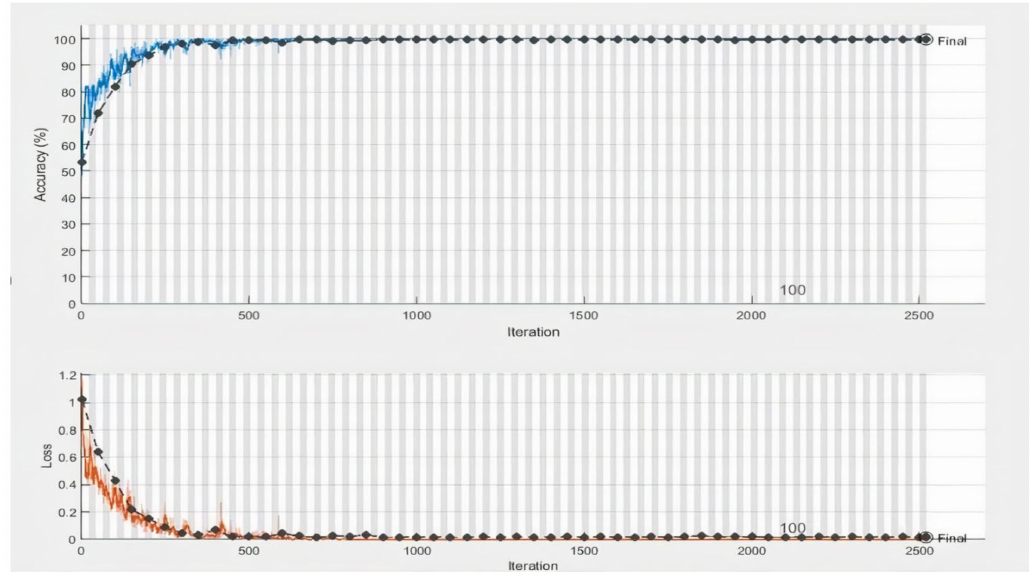
Figure 3. Classification performance (accuracy (%)) of the proposed hybrid